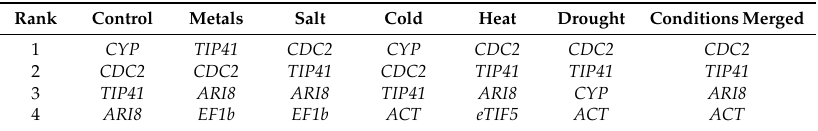
Table 7. Consensus ranking of the 14 candidate RGs to normalize qPCR data in Salix viminalis roots exposed to various abiotic stresses for up to two months. Plants were exposed to the stresses for up to two months. This consensus ranking list was generated by RankAggreg. Genes are listed from top to bottom in order of decreasing expression